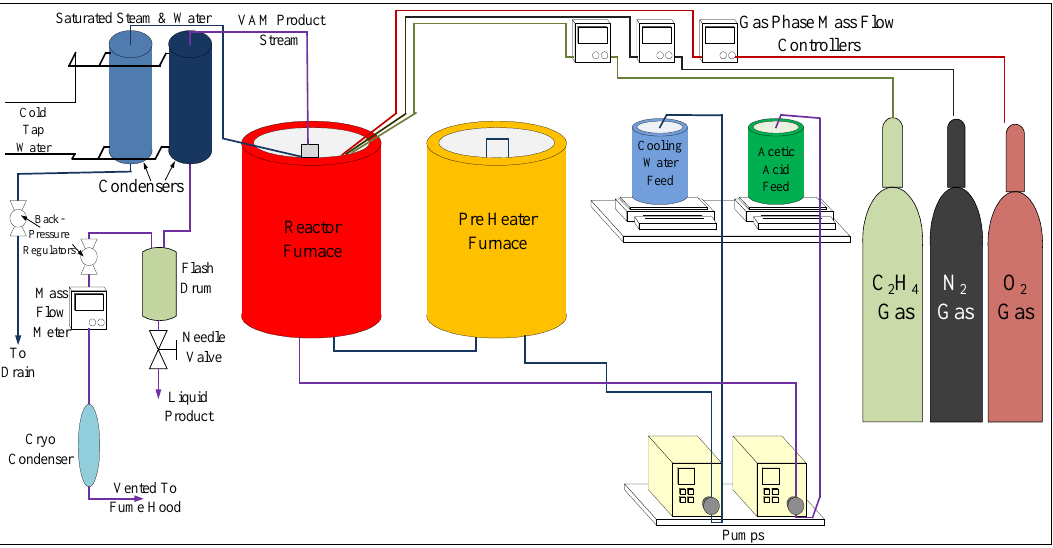
Figure 6. The VAM reaction